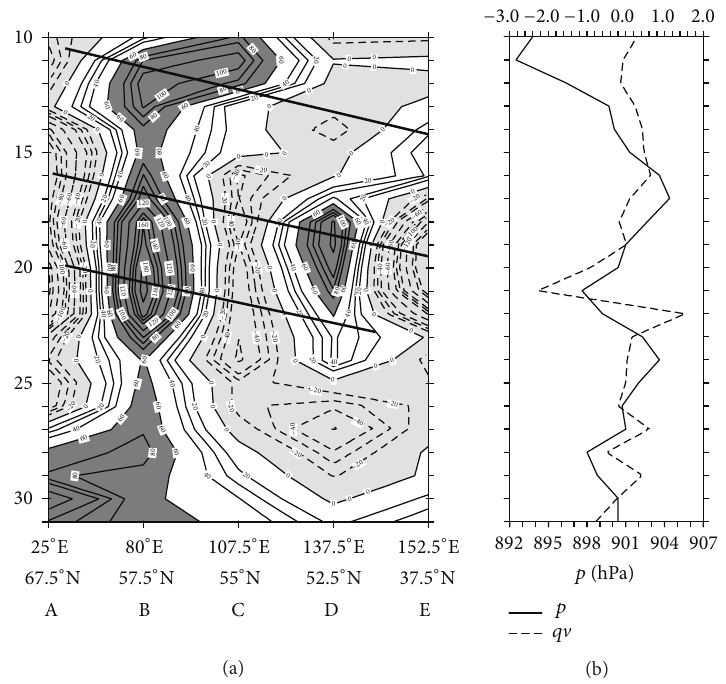
Figure 6: The time evolution of daily 500 hPa geopotential height deviations (contour interval: 10 gpm) along A–F (Figure 4) (a) and surface pressure (solid line, unit: hPa) and 850 hPa water vapor flux divergence (dashed line, unit: kg/(s ∗ hPa ∗ m 2 )) in Beijing (b) from July 10 to 31,